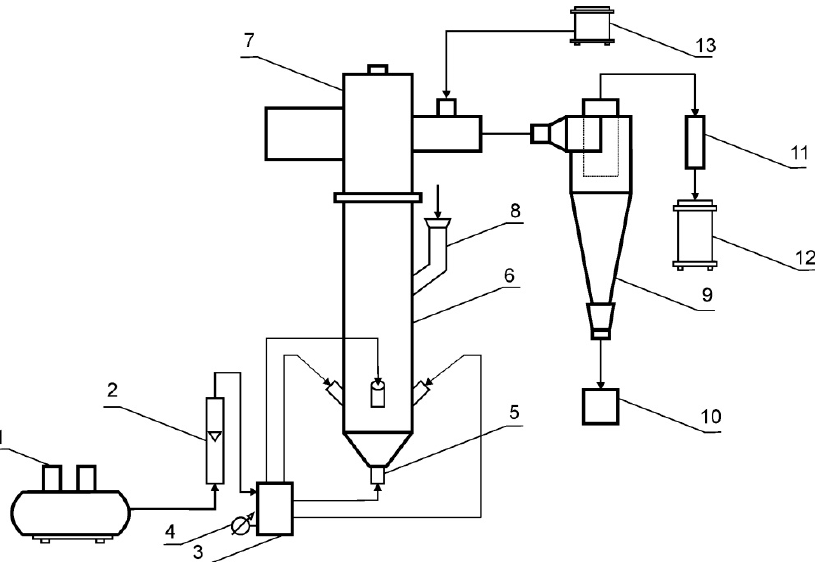
Figure 1. Schematic diagram of the experimental set-up; 1—compressor, 2—rotameter, 3—working air collector, 4—elastic pressure gauge, 5—air nozzles, 6—grinding chamber, 7—rotational flow classifier with the electric motor, 8—feed material filling container, 9—cyclone, 10—grinding product I box, 11—cloth filter (grinding product II), 12—vacuum for exhaust air, 13—vacuum for seal air.